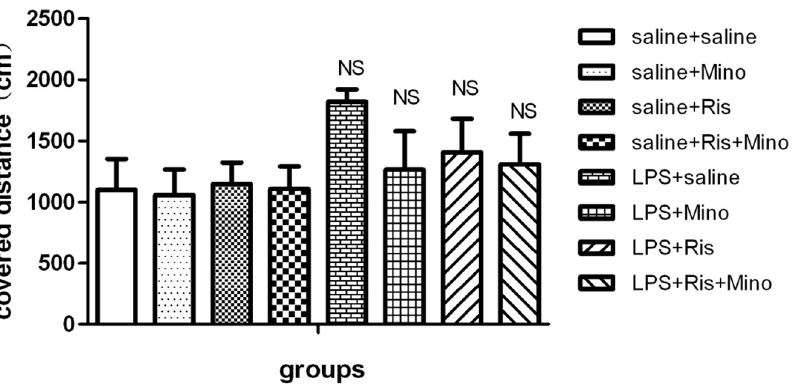
Figure 2. Effects of minocycline, risperidone and combination of these two supplementation and LPS treatment on open-field task. NS represents no significance. The data is shown as means 6 SEM. n=8 for each group.